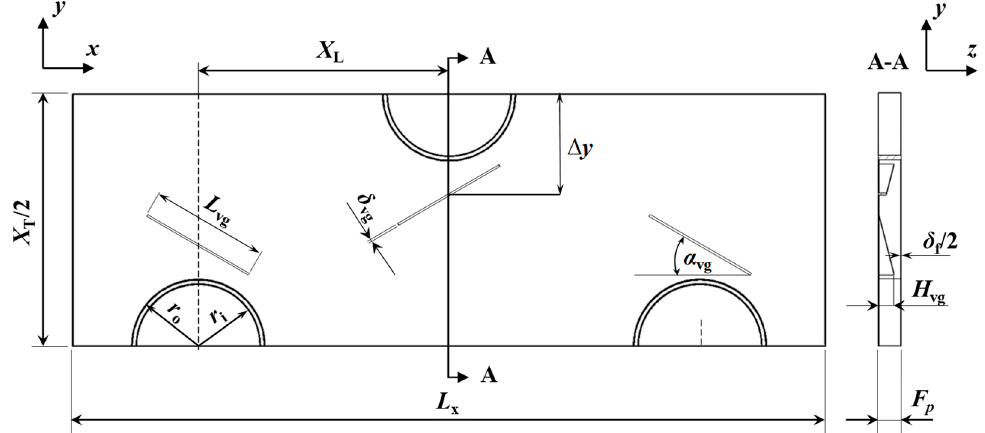
Figure 3. Dimensions of fin-and-tube heat exchanger with delta-winglet vortex generators.